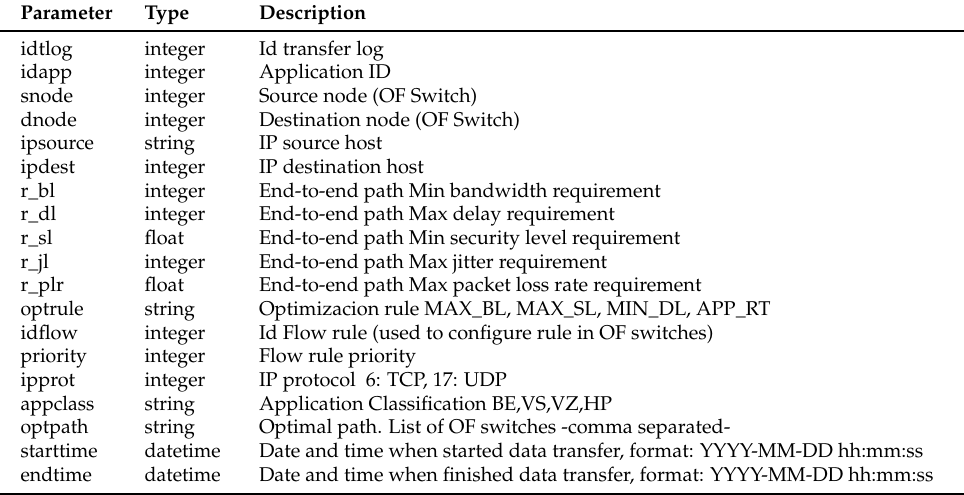
Table 3. RESOURCE: